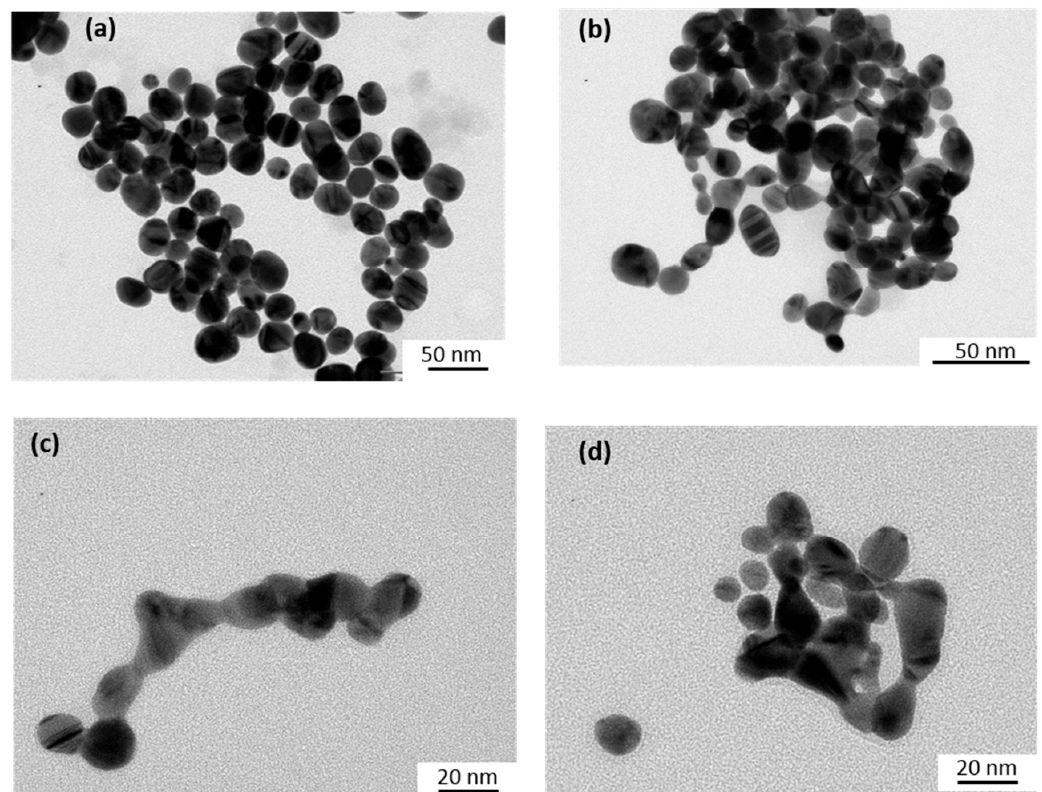
Figure 6. TEM images of initial 30 nm Au-NPs@citrate taken at different times of irradiation during the reduction reaction of hexacyanoferrate (III) by sodium thiosulfate under irradiation with a Xe lamp equipped with a cutoff filter at 450 nm: ( a ) before irradiation; and after ( b ) 30 minutes; ( c ) 120 minutes; and ( d ) 180 minutes of irradiation.